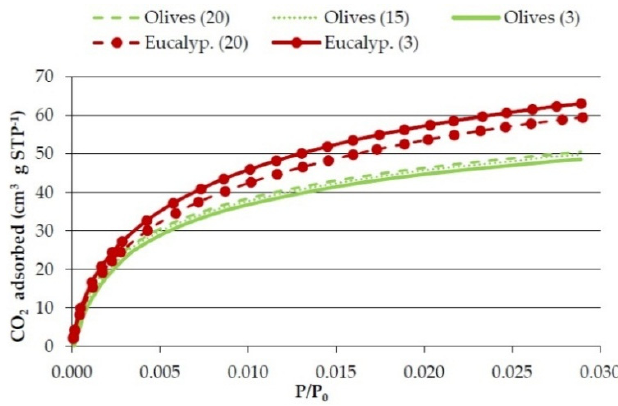
Figure 3. Effect of heating rate on CO 2 adsorption isotherms of the bioreducers obtained at 750 °C from the olives and eucalyptus samples.